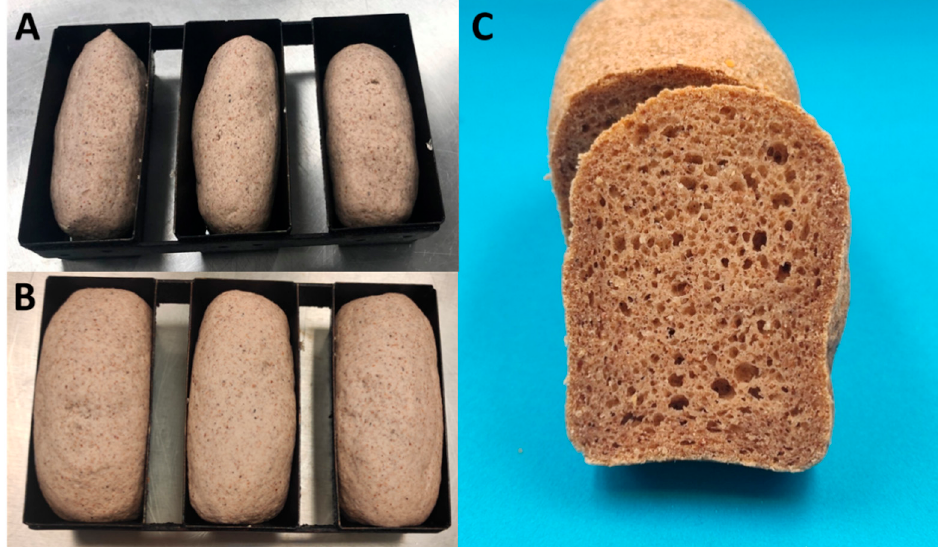
Figure 6. CRC bread dough after mixing and molding in tins ( A ), after proofing ( B ) and the resulting baked bread ( C ) .